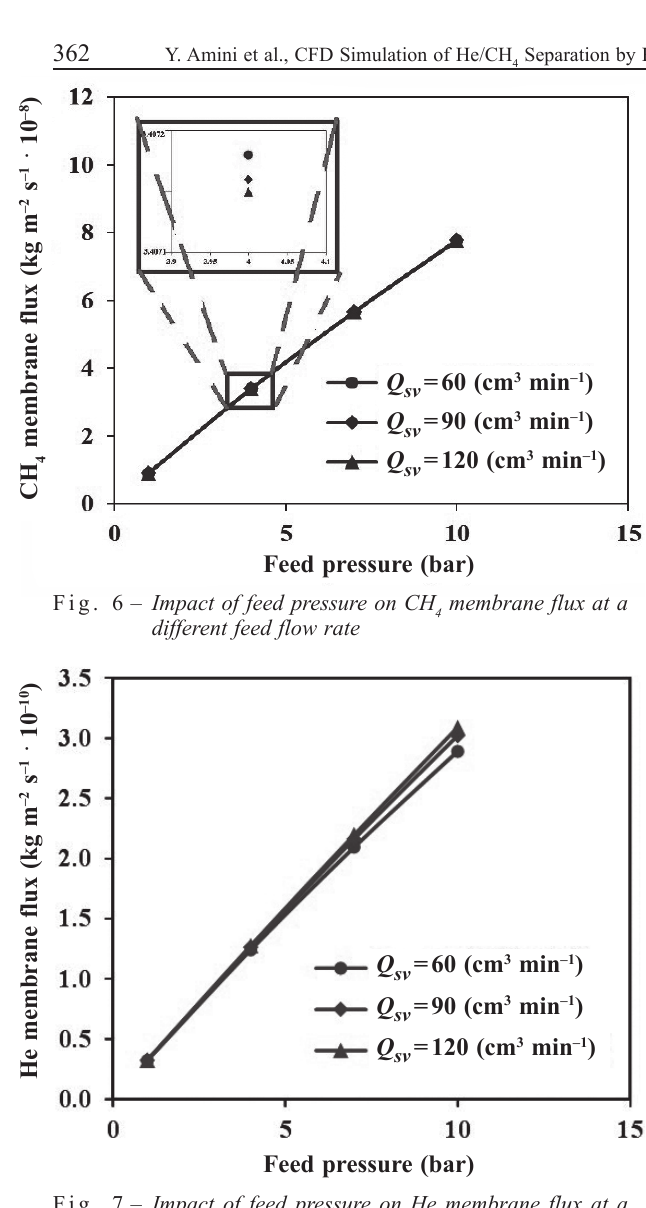
Fig. 7 – Impact of feed pressure on He membrane flux at a different feed flow rate